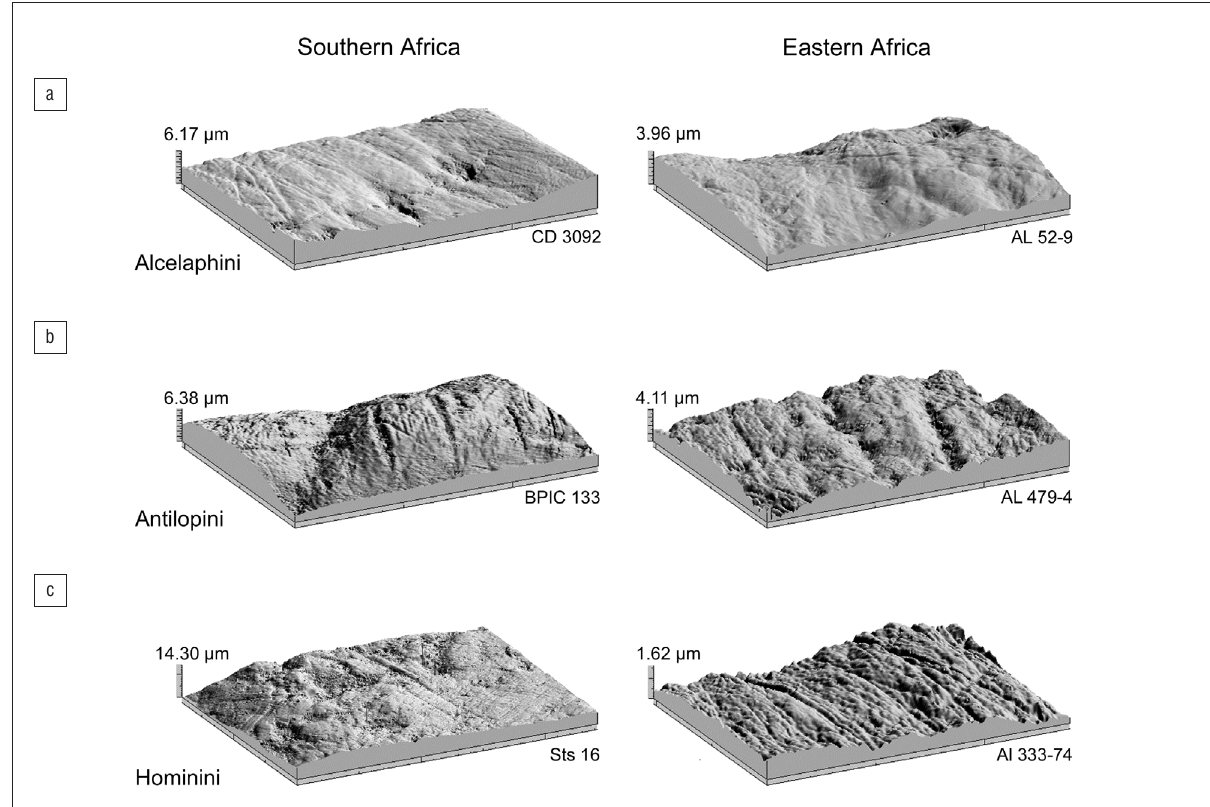
Figure 1: Sample photomicrowear simulations for specimens from southern Africa (left) and eastern Africa (right) representing (a) Alcelaphini, (b) Antilopini and (c) Hominini. Each surface represents an area 138x102